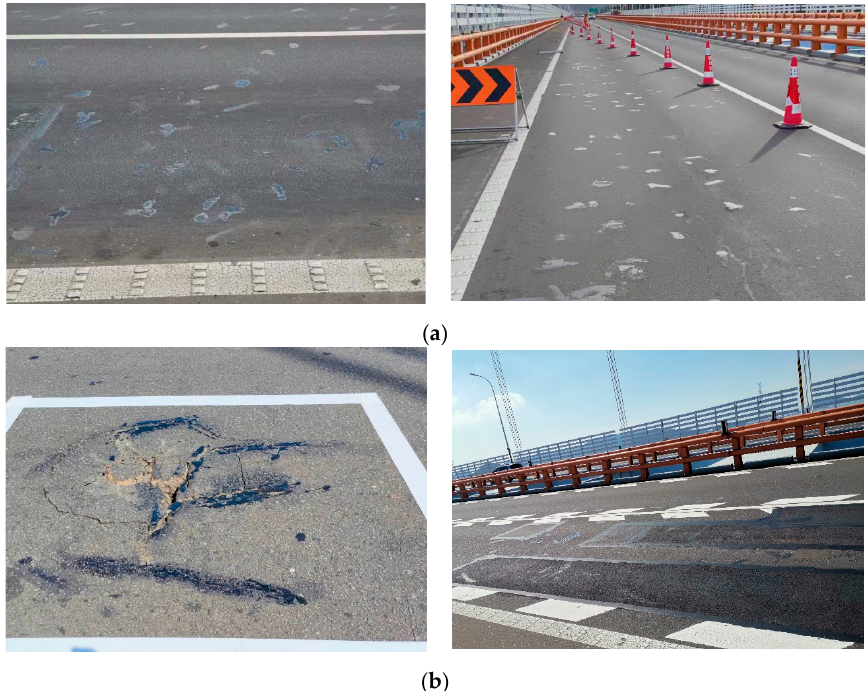
Figure 9. Typical distresses of XHMB pavement: ( a ) cracks; ( b ) pothole and patching. As demonstrated in Figure 9, short cracks emerge densely on the pavement